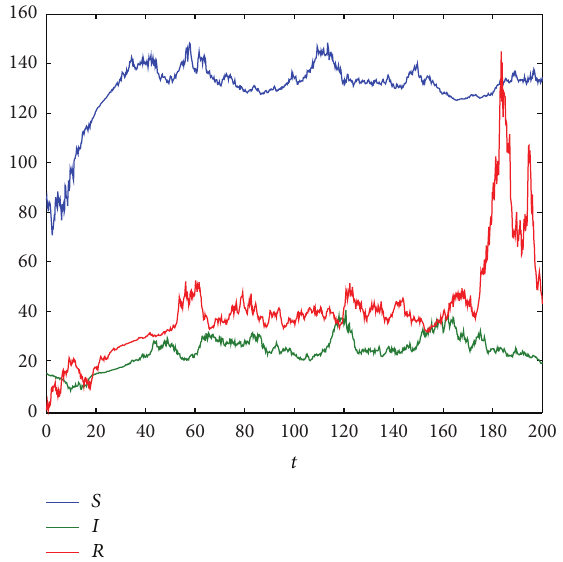
Figure 3: The global stability of the endemic equilibrium 𝐸 ∗ = (𝑆 ∗ , 𝐼 ∗ , 𝑅 ∗ ) for model (47) with initial values 𝑆(0) = 85 , 𝐼(0) = 15 , and 𝑅(0) = 0 . The parameters are taken as 𝑏 = 5 , 𝑑 = 0.01 , = 0.002 , 𝛽 = 0.0018 , 𝑚 = 30 , 𝛿 = 0.1 , 𝜇 = 0.05 , 𝛾 = 0.01 , 𝛽 1 2 = 0.18 , 𝜎 = 0.18 , and 𝜎 = 0.22 𝜎 1 2 3